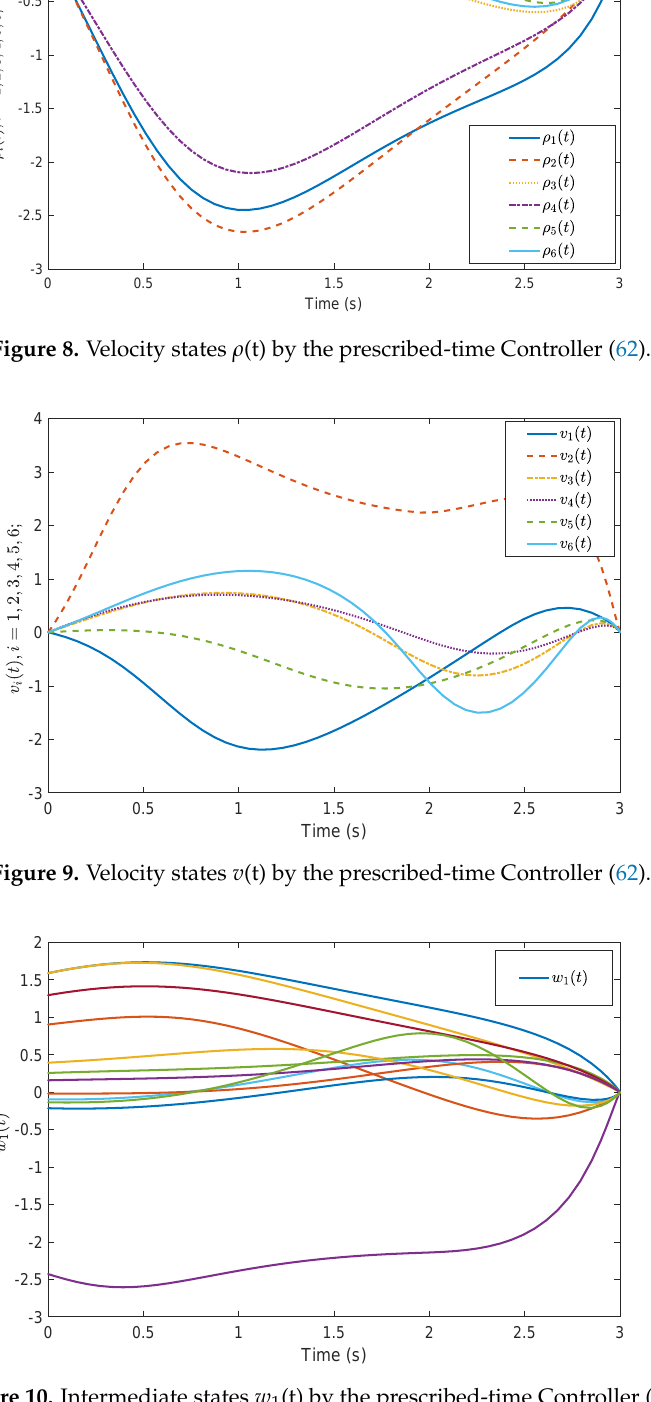
Figure 10. Intermediate states w 1 (t) by the prescribed-time Controller